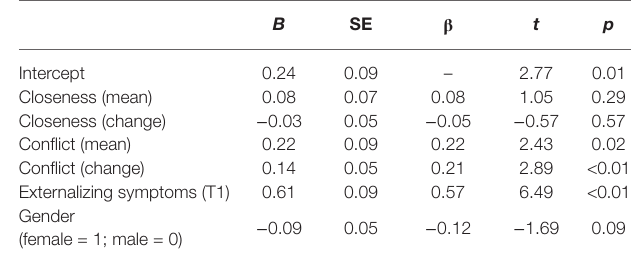
TABLE 2 | From kindergarten to primary school: T2 externalizing symptoms on student-teacher relationship scale variables ( N = 104; R 2 = 0.46). B SE p Intercept